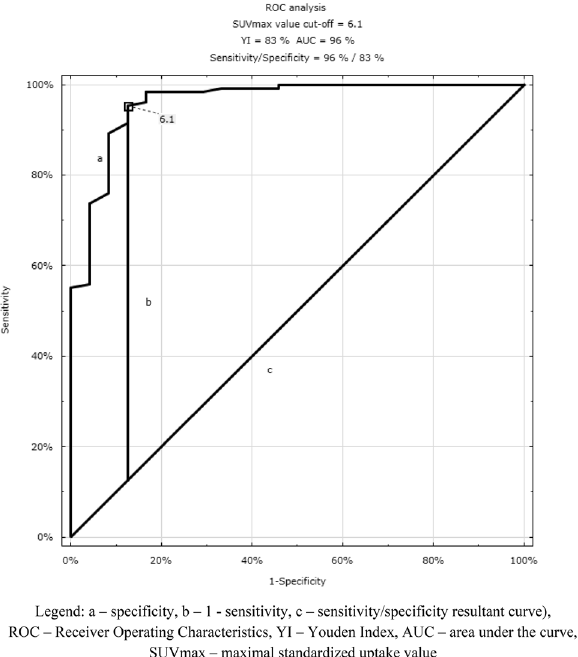
Figure 3. SUVmax value cut-off: benign and malignant brain lesion ( source : original figure, STATISTICA, Statsoft). ( a ) specificity, ( b ) 1—sensitivity, ( c ) sensitivity/specificity resultant curve), ROC Receiver Operating Characteristics, YI Youden Index, AUC area under the curve, SUVmax maximal standardized uptake